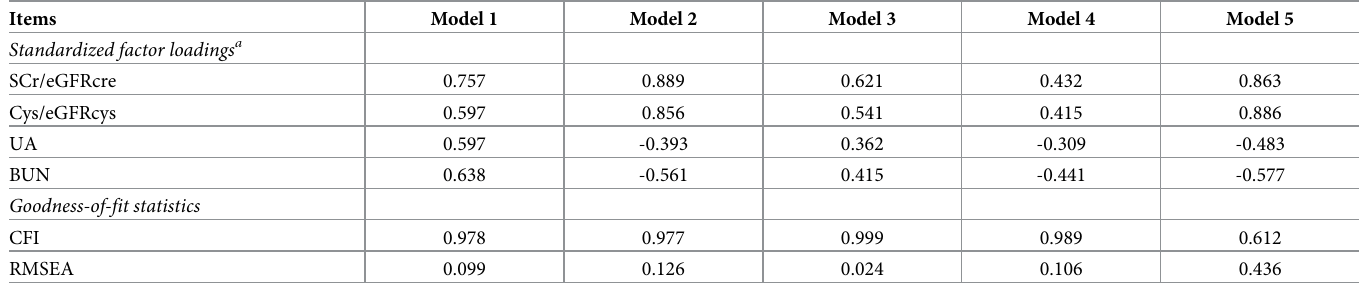
Table 2. Factor loadings and goodness-of-fit statistics for the five SEM models.